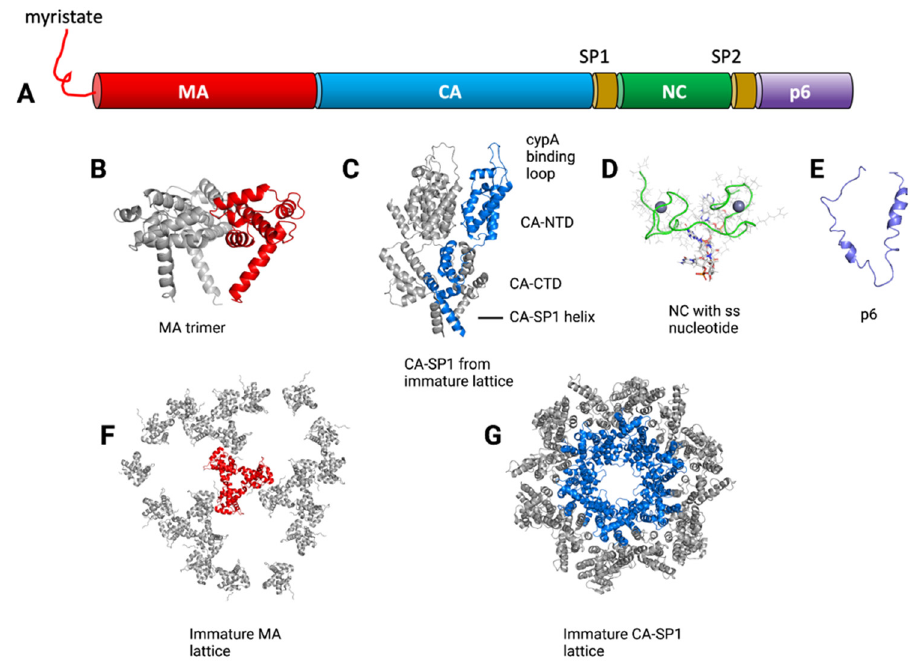
Figure 3. Gag polyprotein with cleavage products. ( A ) Schematic diagram showing cleav- age products/domains in different colors. ( B ) MA trimer structure from PDB 1HIW [39]. ( C ) CA-SP1 structure, side view, with one CA NTD -CA CTD -SP1 colored in blue, from PDB 5L93 [40]. Note cyclophilin A (cypA) binding loop, CA NTD and CA CTD connected by flexible loop, and CA-SP1 helix. ( D ) NC structure with single-stranded oligonucleotide (ss nucleotide), from PDB 1BJ6 [41]. Zinc ions shown as spheres. ( E ) p6 structure from PDB 2C55 [42]. ( F ) Immature MA lattice, top view, with single trimer in red; from PDB 7OVQ [43]. ( G ) Immature CA-SP1 lattice, top view, with single hexamer colored blue, from PDB 4USN [44]. Structures rendered by the PyMOL Molecular Graphics System, Shrodinger, LLC. The arrangement of this figure was adapted from [45]. Figure compiled using BioRender.com (2022).